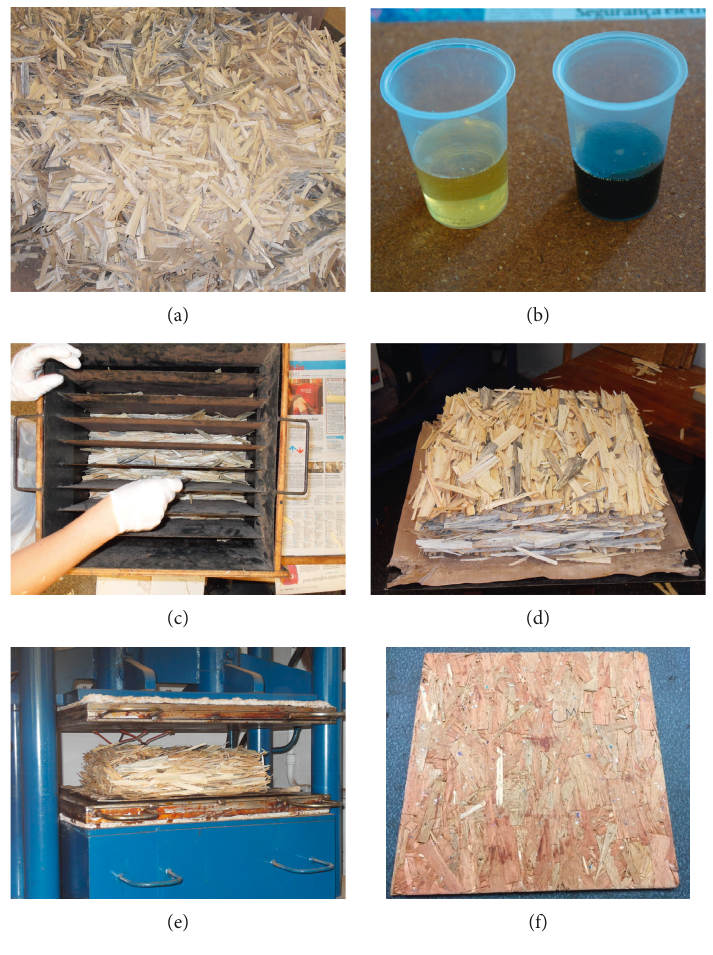
Figure 1: Steps of OSB production. Table 1: Experimental design. Table 2: Number of determinations for each property and for each wood species